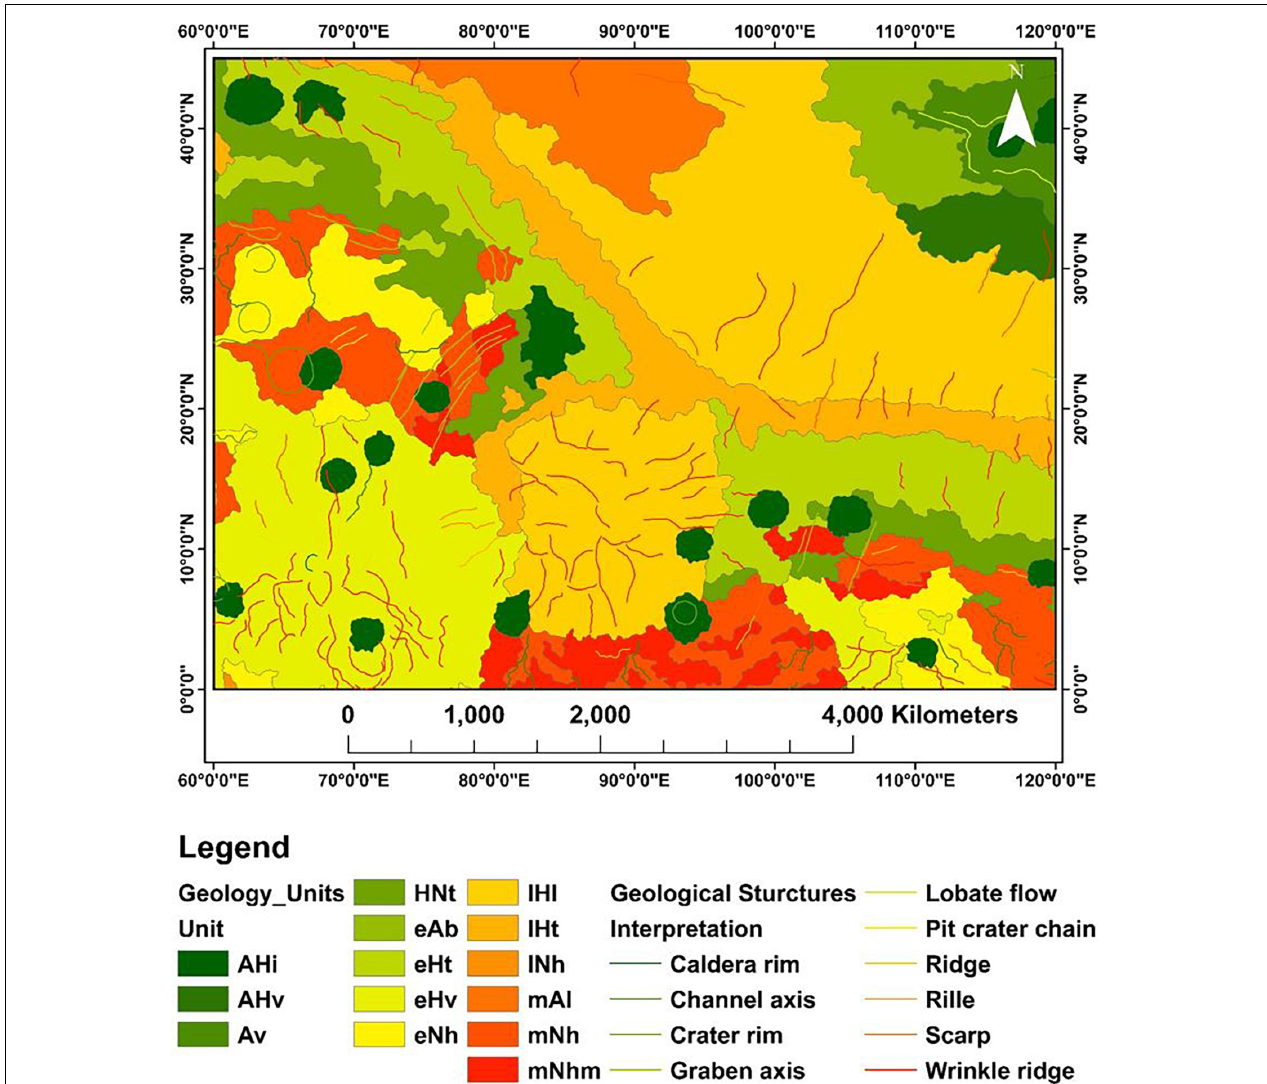
FIGURE 4 | Detailed geological map of the study area, in which the geological units are subdivided in 14 geological units along with the major geological structures. A description of the geology units is mentioned in